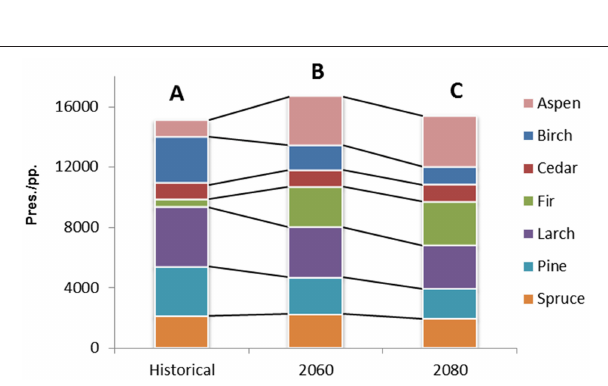
FIGURE 6 | Cumulated forest species distribution in terms of count of map units (pixels) with presence (pres.; for the historical period) and projected presence (pp.; for the future periods). Different capital letters mean that the distributions are significantly different at the 99.9% level ( p <